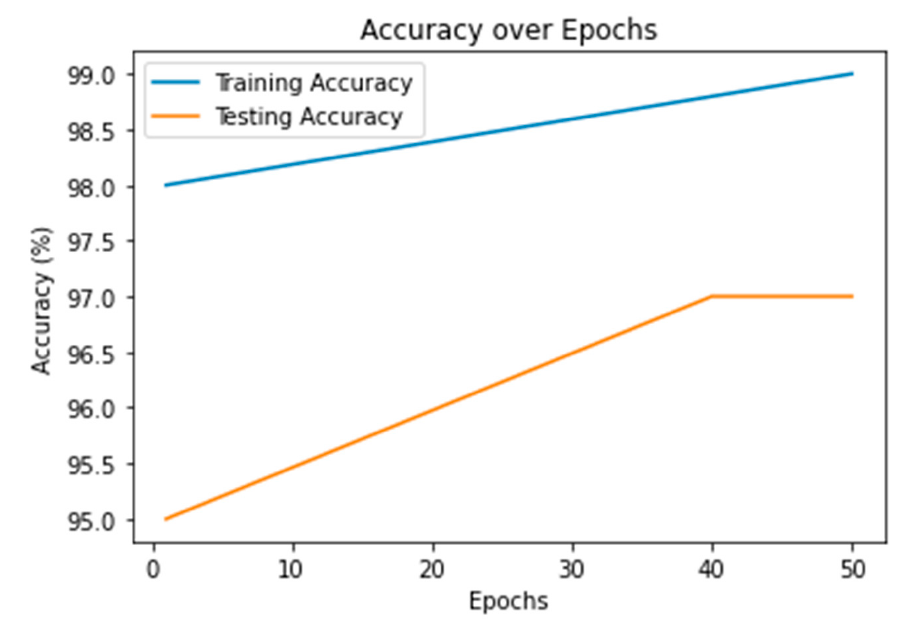
Figure 9. Accuracy of fine-tuned 3D U-Net classifier.